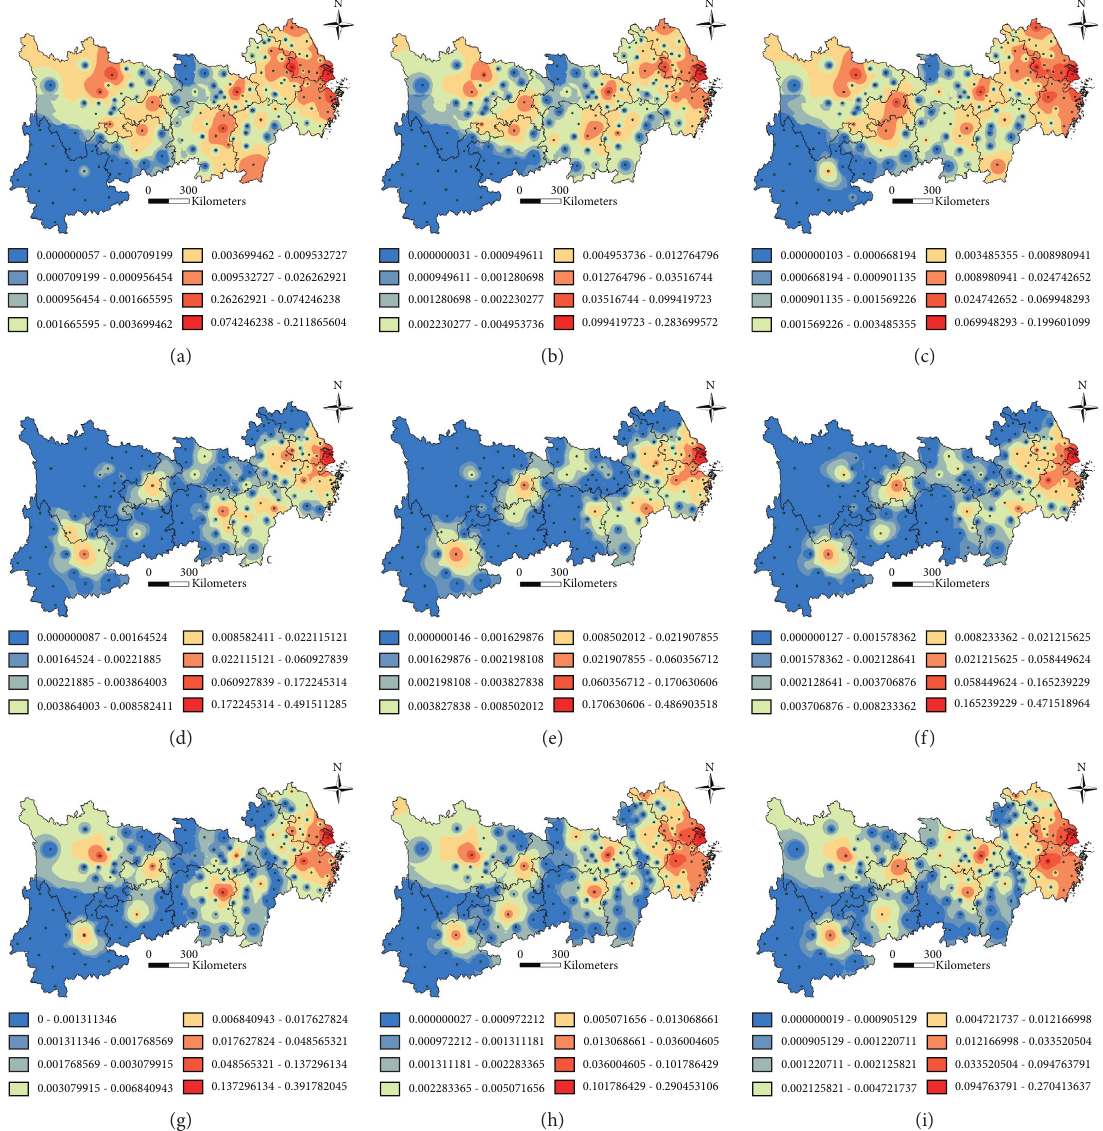
Figure 8: The spatial agglomeration of the specialization levels of listed companies in three major industrial types in (a, d, g) 2008; (b, e, h) 2013; and (c, f, i)